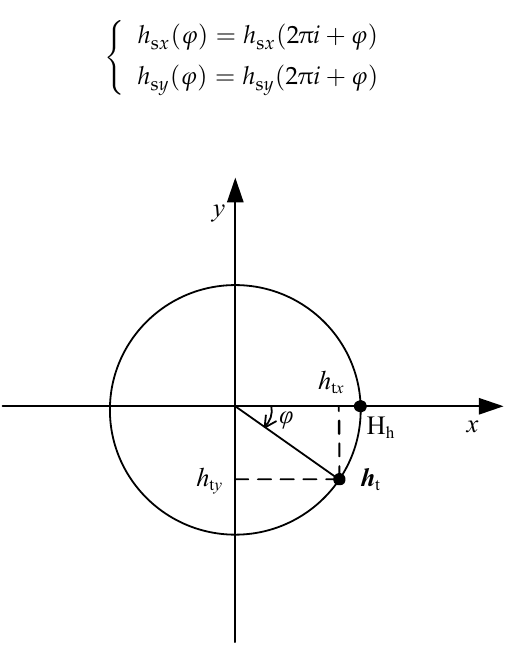
Figure 1. Relationship between the true value of magnetic field vector t h and the reference heading .